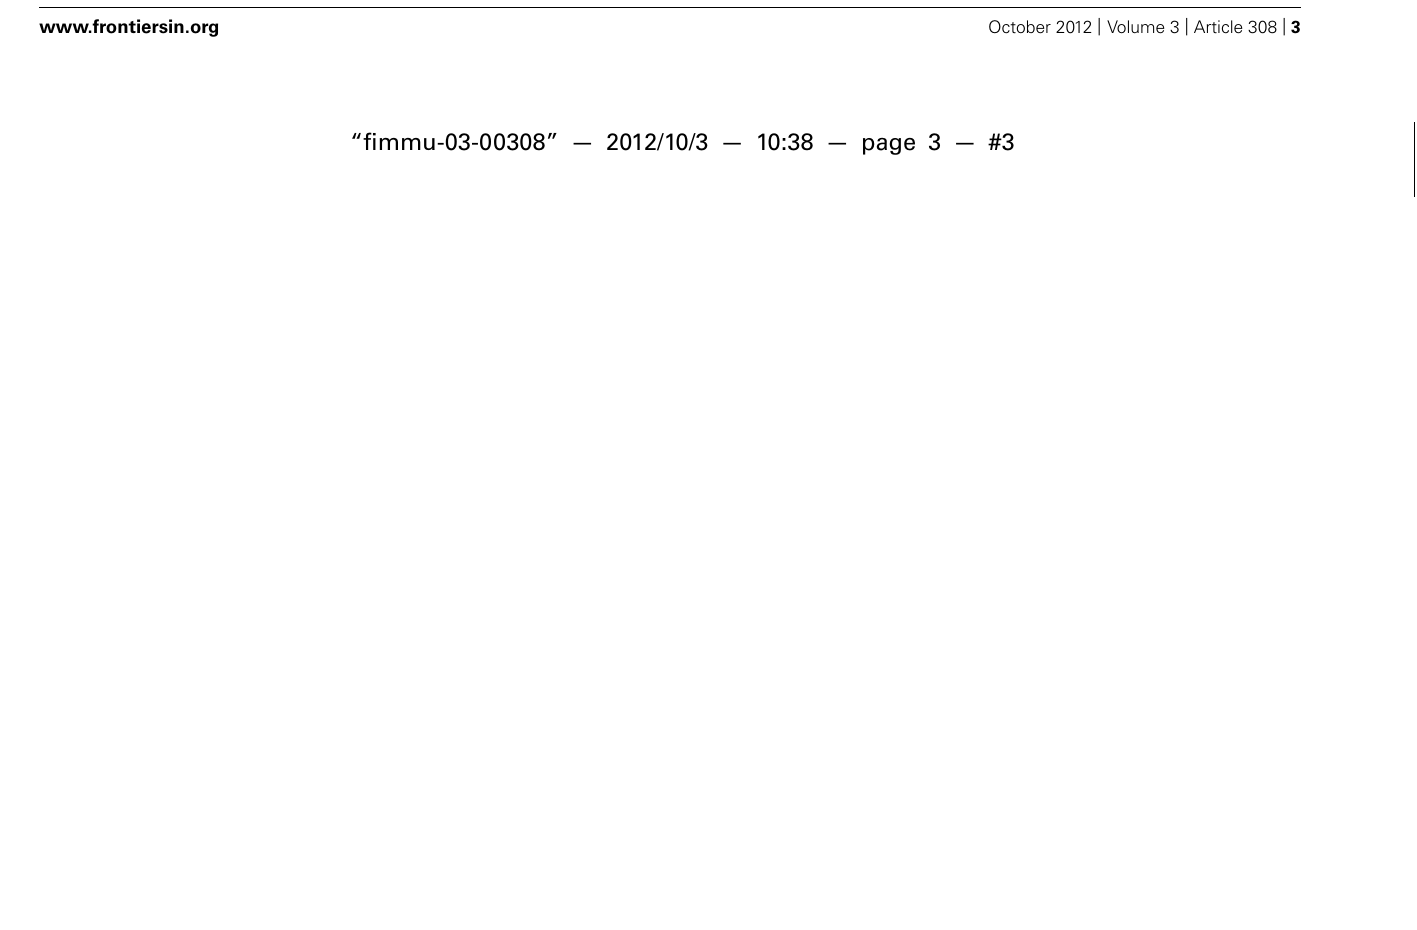
Table summarizing the main high- and super-resolution technologies mentioned in the main text and comparing some of their major advantages and limitations.